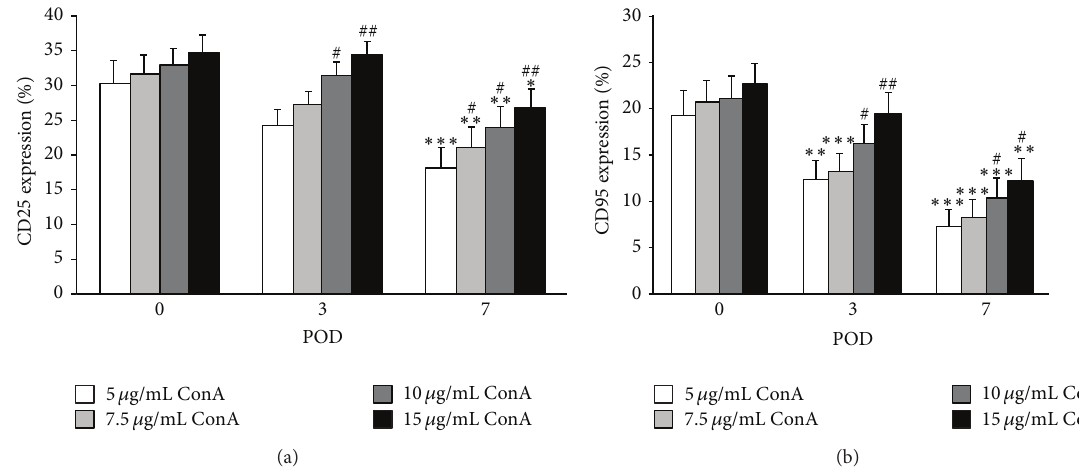
Figure 1: Expression of CD25 (a) and CD95 (b) on whole CD3 + T cells population after stimulation with different concentrations of ConA preoperatively (POD-0) and on postoperative days (POD)-3 and -7. Data are represented as mean ± S.E.M. Statistics: Mann-Whitney versus POD-0; ∗ 𝑃 < 0.02 ; ∗∗ 𝑃 < 0.01 ; ∗∗∗ 𝑃 < 0.001 . Mann-Whitney versus 5 𝜇 g/mL ConA; # 𝑃 < 0.05 ; ## 𝑃 < 0.01 .